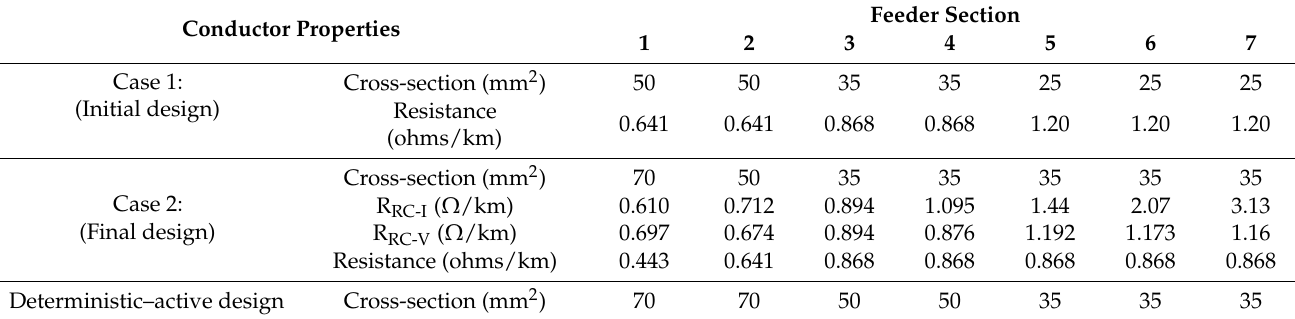
Table 4. Conductor properties for the passive (initial) and adjusted feeder